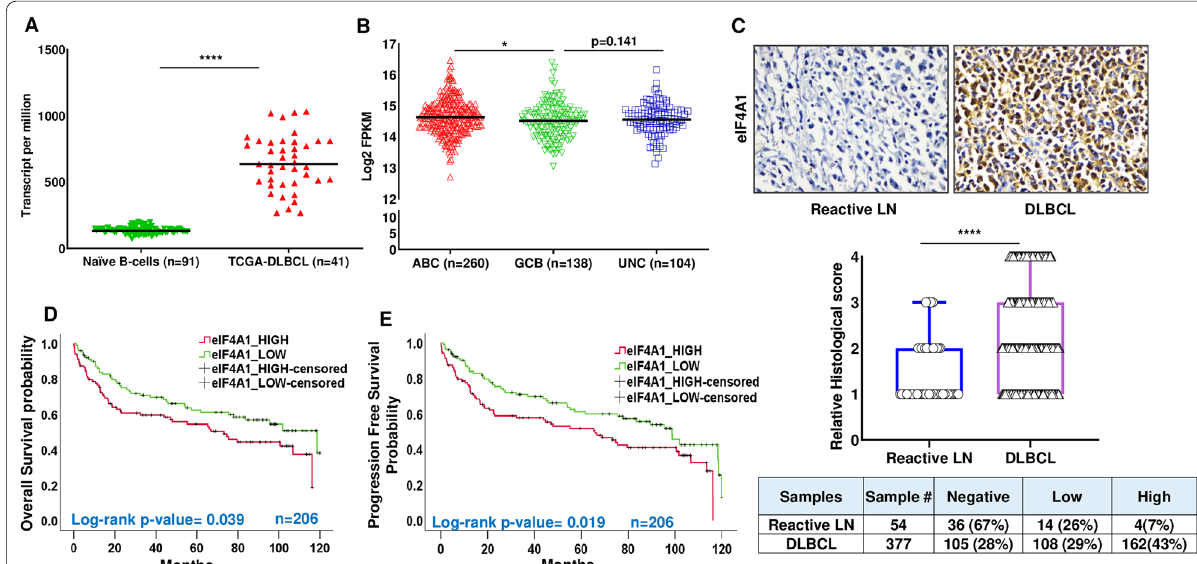
Fig. 1 Clinicopathologic evaluation of eIF4A1. A Representative plots show RNA-seq expression profiles of eIF4A1 in naïve B-cells (n 91) (obtained = from DICE database https:// dice- datab ase. org/) compared with DLBCL (n 41) in TCGA dataset. eIF4A1 showed significantly higher expression = in tumor samples compared with control. The Y-axis represents transcript per million (TPM) values. ****p < 0.0001. B Comparison of RNA-seq data of eIF4A1 in molecular subgroups using a publicly available large dataset of patients with DLBCL. eIF4A1 showed significantly higher expression in ABC-DLBCL (n 260) subgroups compared with GCB-DLBCL (n 138) and UN-DLBCL (n 104), *p < 0.05. The values are represented in log = = = base 2 of fragments per kilobase of exon per million mapped fragments (FPKM). C Representative immunohistochemistry image of commercially procured (US Biomax., Inc) TMA slides stained with eIF4A1 antibody. Representative scatter plots showing the stained signals of eIF4A1 in reactive LN compared to DLBCL samples. Statistical analysis was performed using Wilcoxon signed-rank test (unpaired two-tailed), **** p < 0.001 vs. reactive LN. Summary chart for DLBCL and normal LN. ve: no staining detected, low: 1–2 staining density, high: 3–4 staining density. D eIF4A1 expression − was found to be significantly ( p 0.039) associated with OS of patients with DLBCL in the publicly available dataset (n 206). Patients with a lower = = median expression of eIF4A1 showed a better prognosis than patients having higher median expression. E eIF4A1 expression was also found to